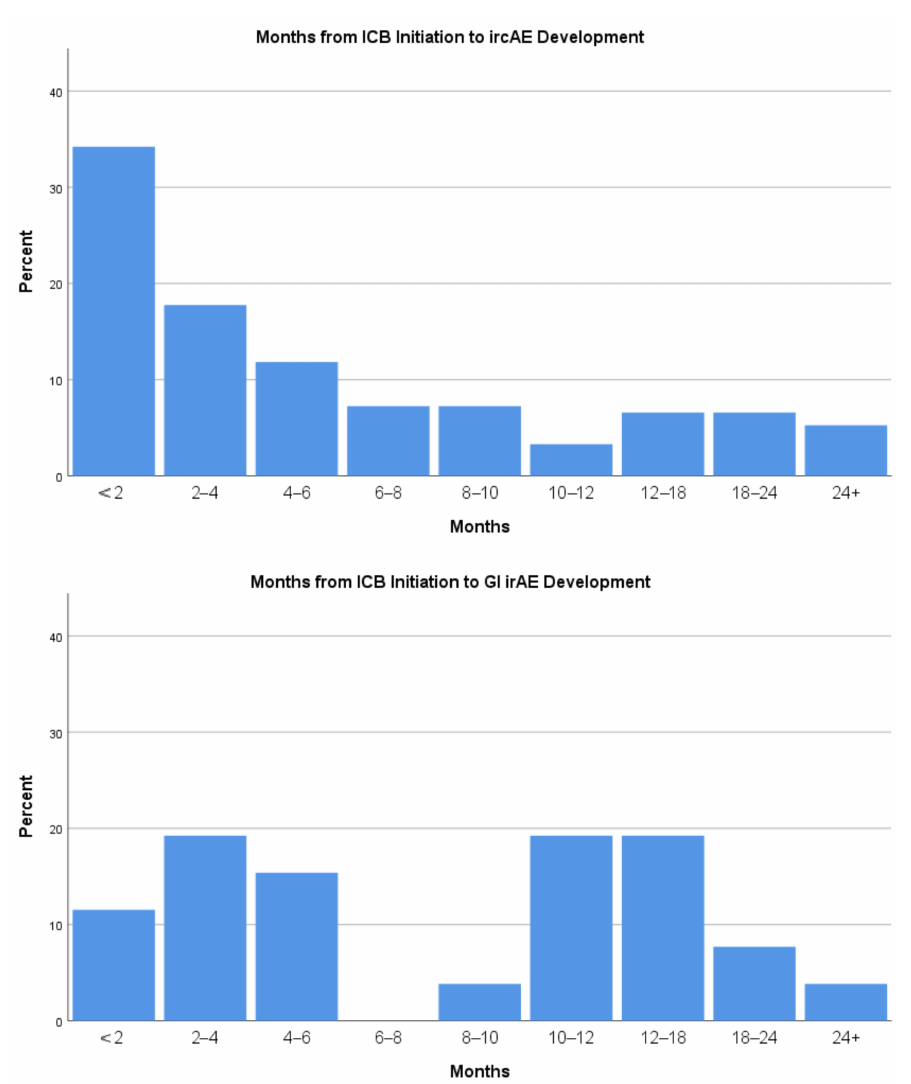
Figure 2. Months from ICB initiation to ircAE and GI irAE